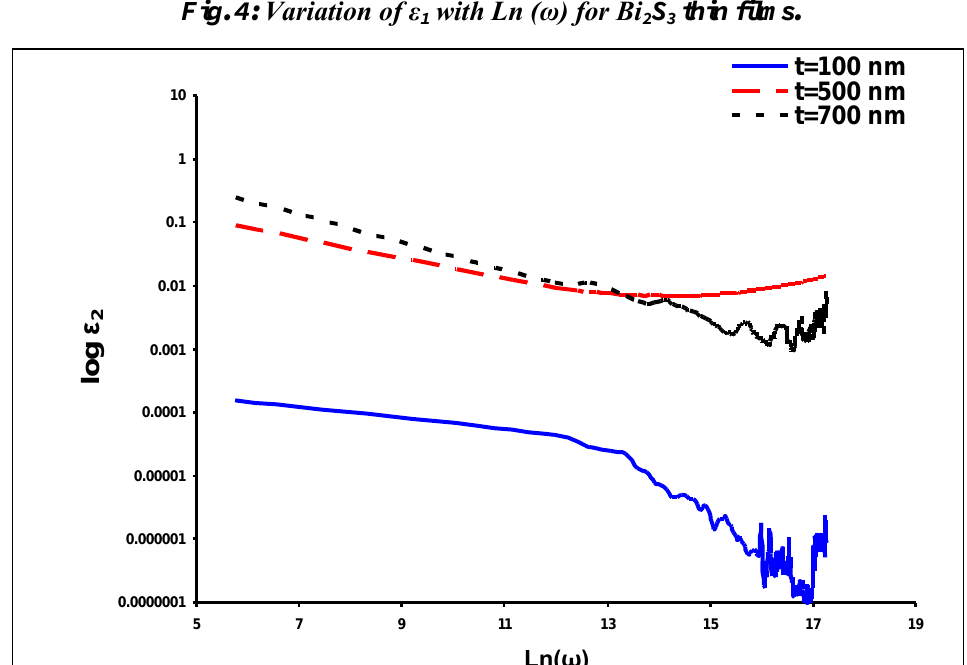
Fig. 4: Variation of ε